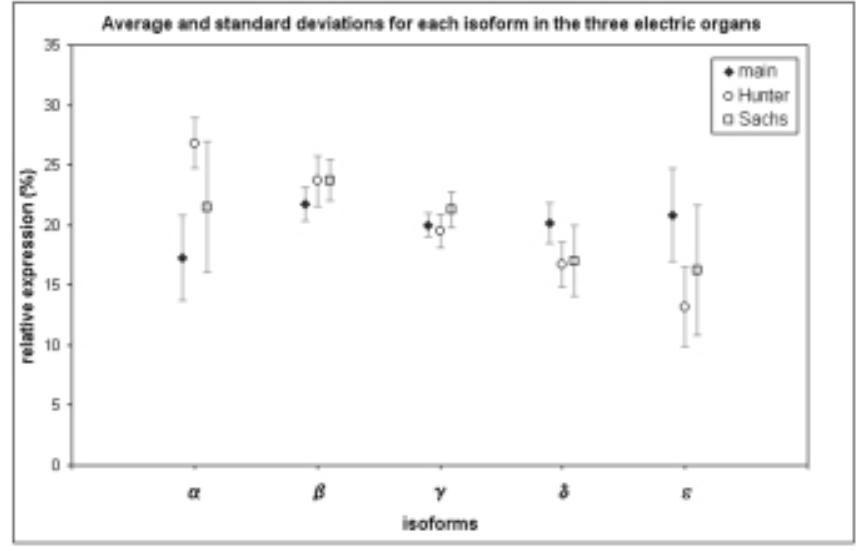
Fig. 3 – Relative expression (% of total of densitometry ± S.D.) of each isodesmin in each electric organ of E. electricus (number of observations: six for main, six for Hunter and four for